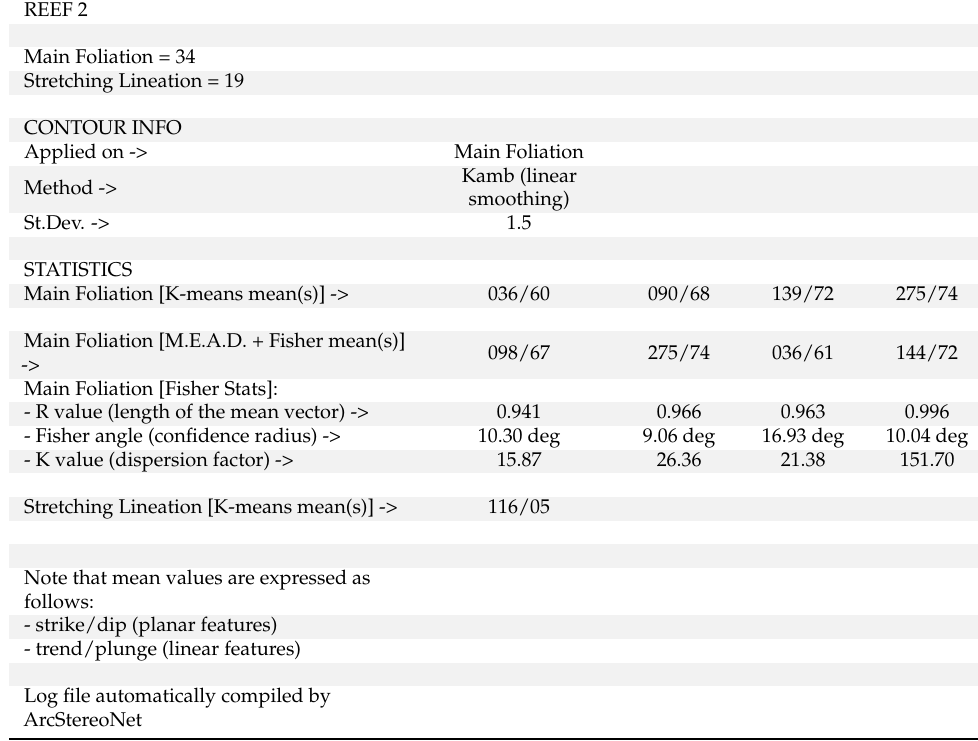
Table A4. ‘Reef 2 (cid:48) station log file. The original .txt file has been converted to table format. REEF 2 Main Foliation = 34 Stretching Lineation =